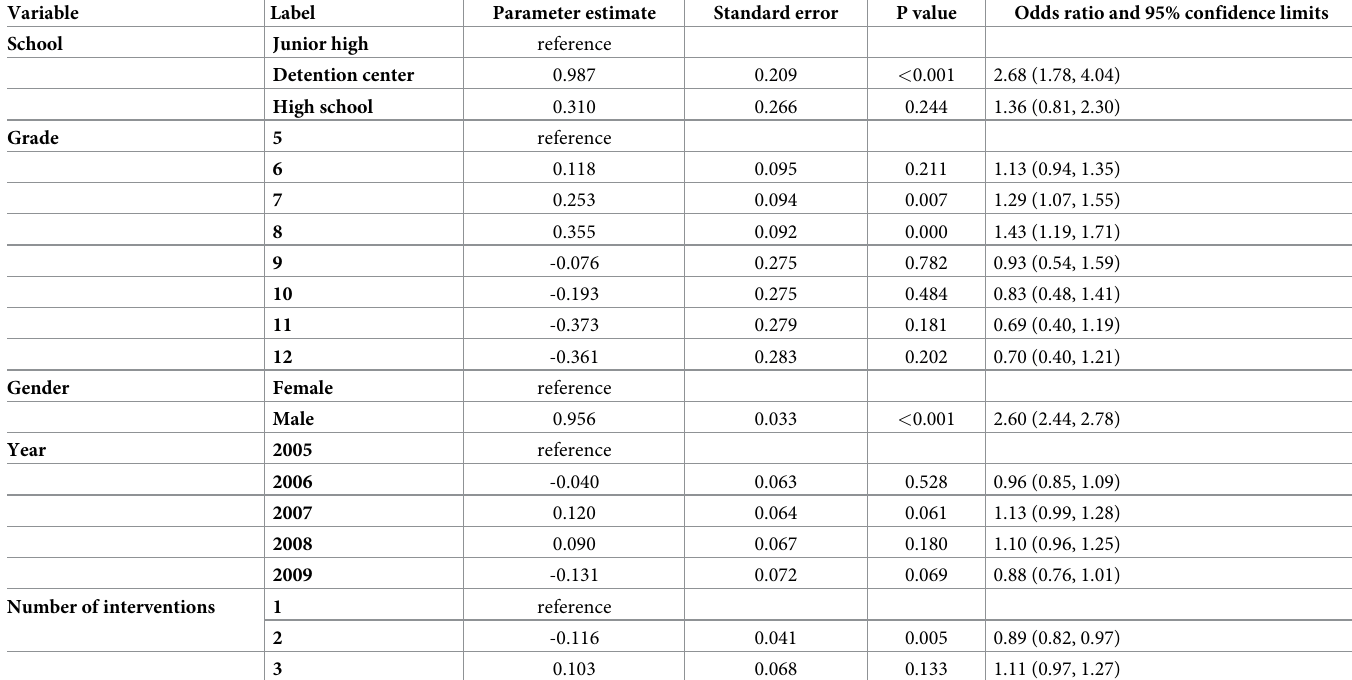
Table 2. Multivariable analysis of problem gambler prevalence using a mixed-effects cumulative logistic regression model.